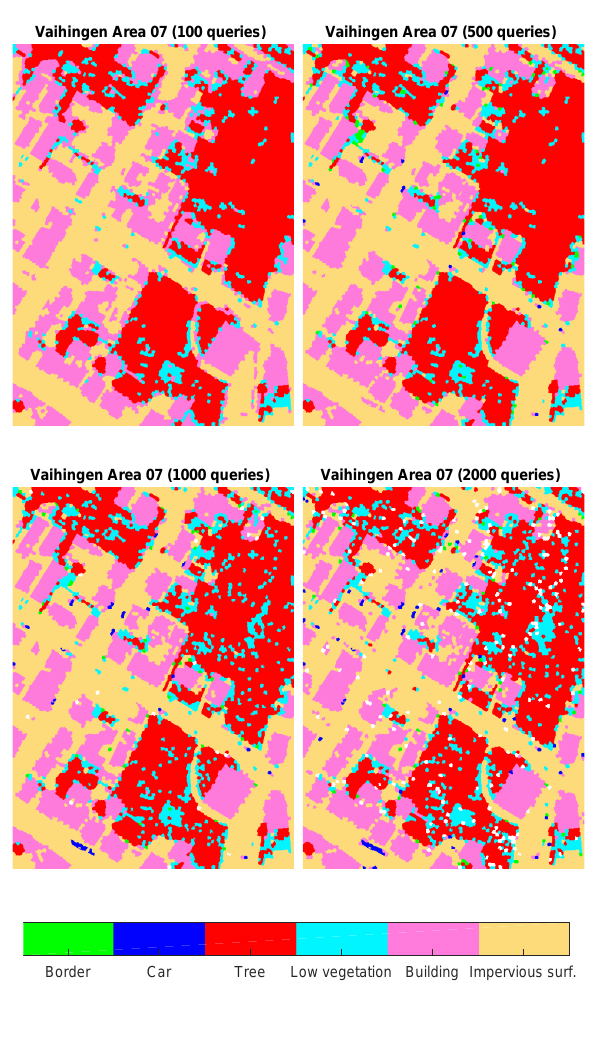
Figure 8. Classification maps at different stages of the learning process. At 100 queries not all classes are discovered. At 500 queries all classes are present and the result looks much like the final result. Between 1,000 and 2,000 queries are not many changes which matches the observations from the learning